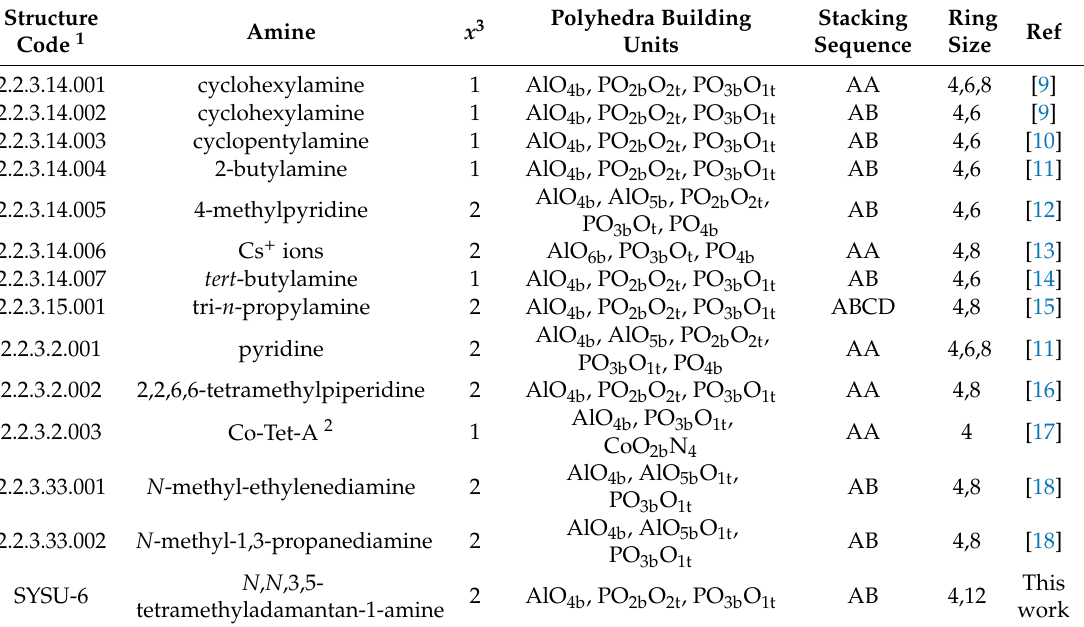
Table 1. Summary of Layered aluminophosphates (AlPO) with Al:P Ratio of 2:3. Structure Amine x 3 Code 1